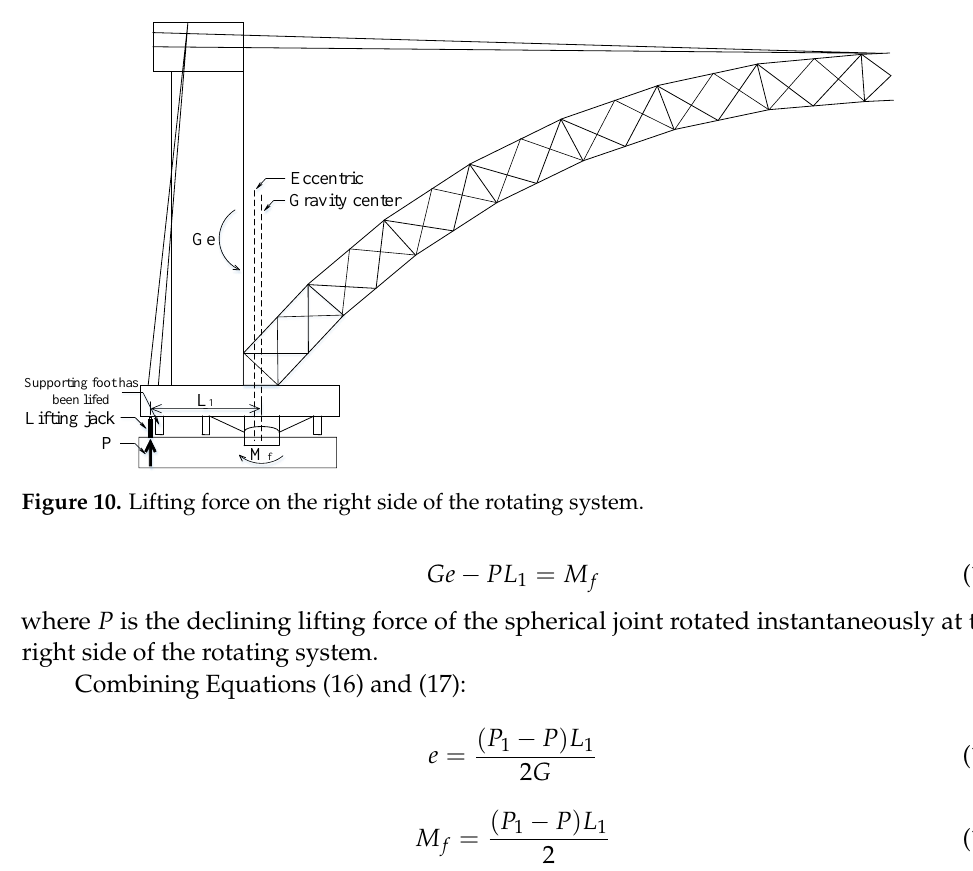
M f P 1 Figure 9. Lifting force on the left side of the rotating system.